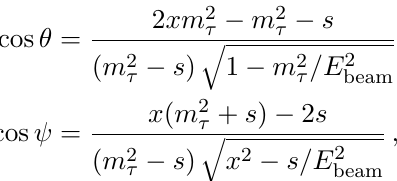
1 . 2 (red dashed line), and 1 . 6 GeV (blue dot-dashed line),